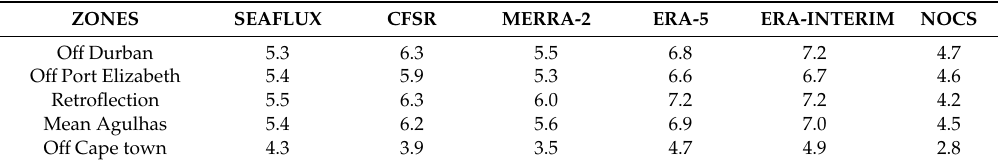
Figure 14 : Annual cycles of the differences between Qss and Qa (g/kg), off Durban, off Port Elizabeth, Retroflection region, and off Cape Town for SEAFLUX (blue), CFSR (red), MERRA-2 (green), ERA-5 (purple), ERA-Interim (yellow) and NOCS (black), with their respective envelopes as in Figure 3. Table 5 : Same as Table 2 but for the differences between sea surface specific humidity and humidity of air (Qss-Qa) (g/kg). The products are averaged using the resampled data on the grid of SEAFLUX (0.25° × 0.25°).